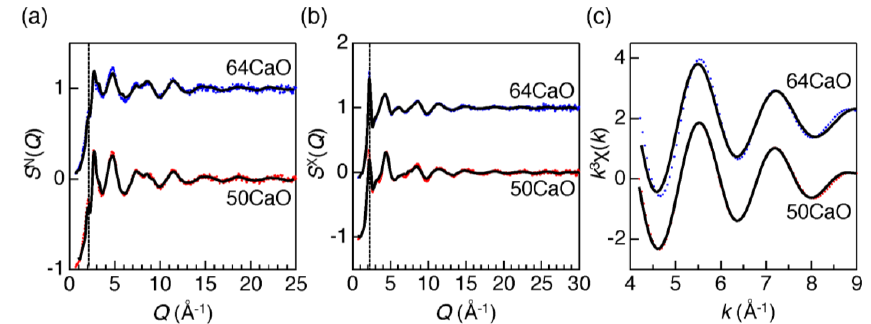
Figure 6. Neutron ( a ) and X-ray ( b ) total structure factors S ( Q ) and ( c ) extended X-ray absorption fine structure (EXAFS) k 3 χ ( k ) data for 50CaO and 64CaO glasses synthesized by CNL technique. The EXAFS k 3 χ ( k ) data were obtained by back Fourier transformation (FT) of the first correlation peak in |FT|. Circles: experimental data; curve: RMC-DFT model [16].